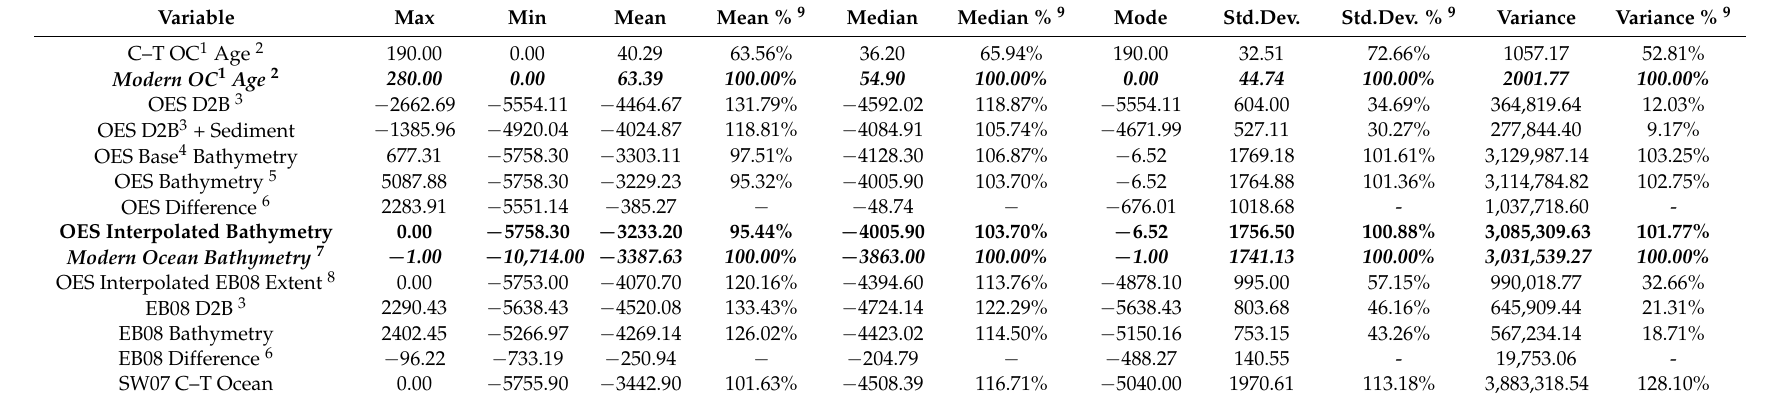
Table 3. Comparative statistics of Open Earth Systems (OES), Modern and EB08